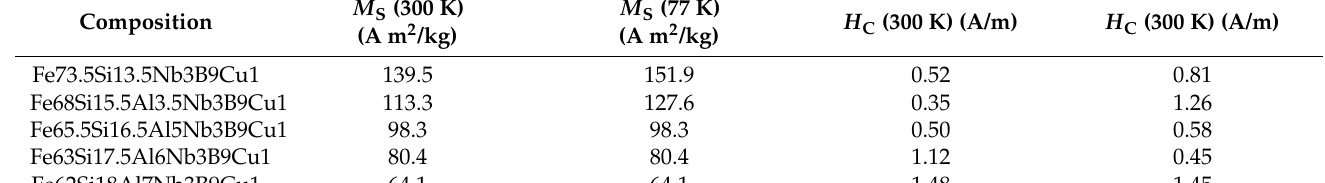
Table 3. Magnetic parameters and resistivity of Fe-based nanocrystalline alloys at 77 and 300 K [151]. Composition